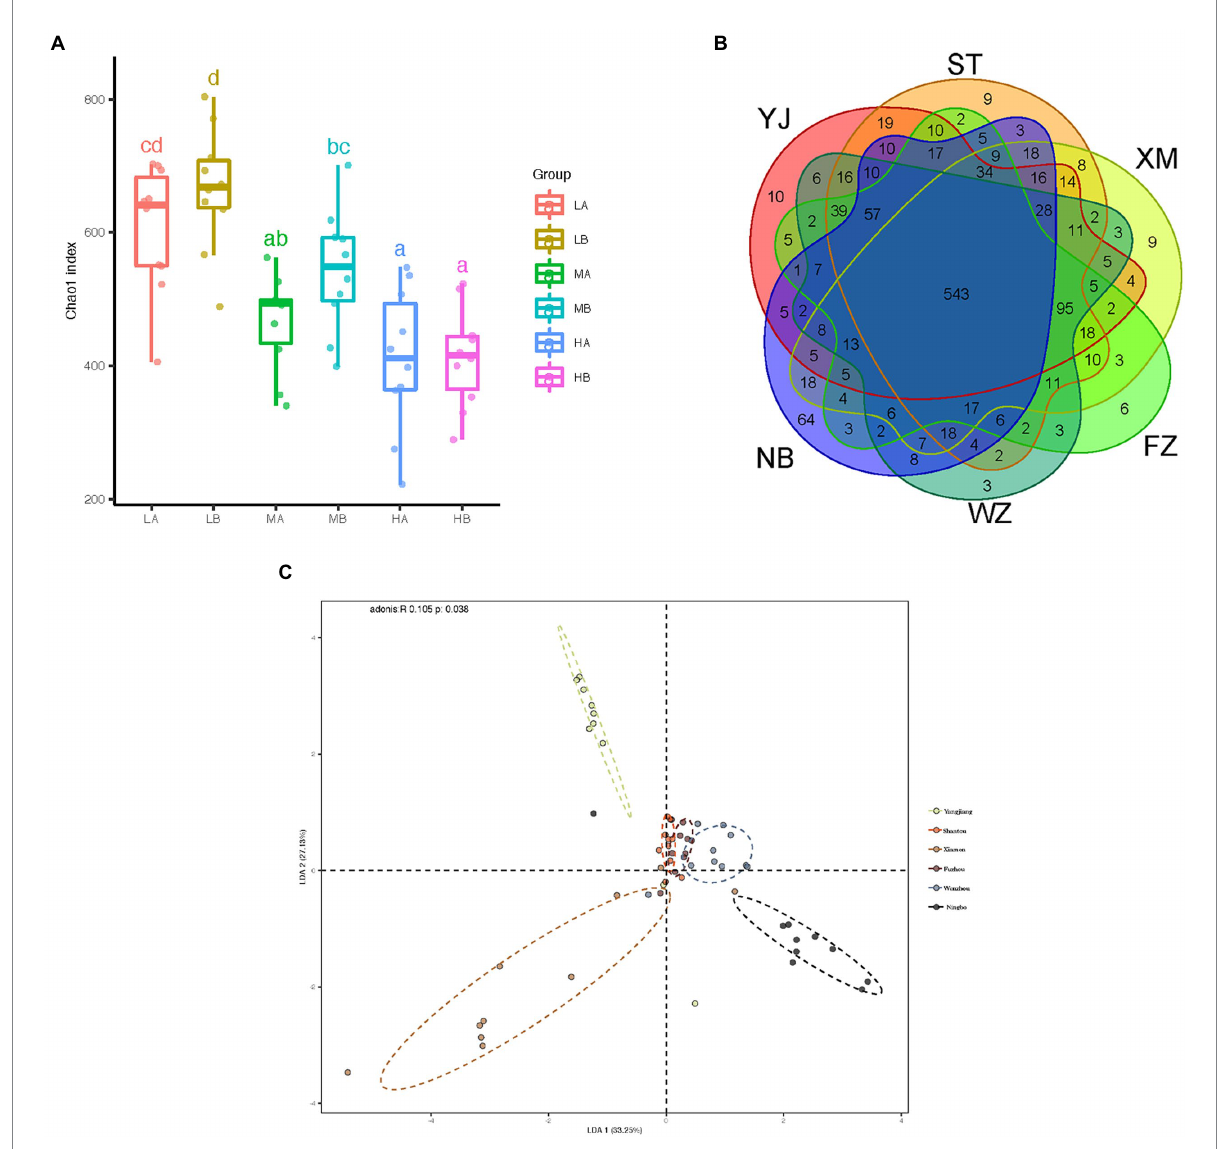
FIGURE 4 Comparison of the composition of fecal microbiota in different geographic populations. (A) Chao1 index of the microbiota of gut microbiota from different populations. The horizontal bars within boxes represent medians. The tops and bottoms of boxes represent the 75th and 25th percentiles, respectively. The upper and lower whiskers extend to data no more than 1.5× the interquartile range from the upper edges and lower edge of the box, respectively. (B) Venn diagram illustrating overlap of OTUs in gut microbiota between different groups. (C) The difference in the composition of the gut microbiota is illustrated by the linear discriminant analysis of the Bray-Curtis distance matrix among samples. All pairwise comparisons involved the first, second and third principal axes. The first, second and third principal axes explained most of the variances (33.25, 27.13, and 39.62%,